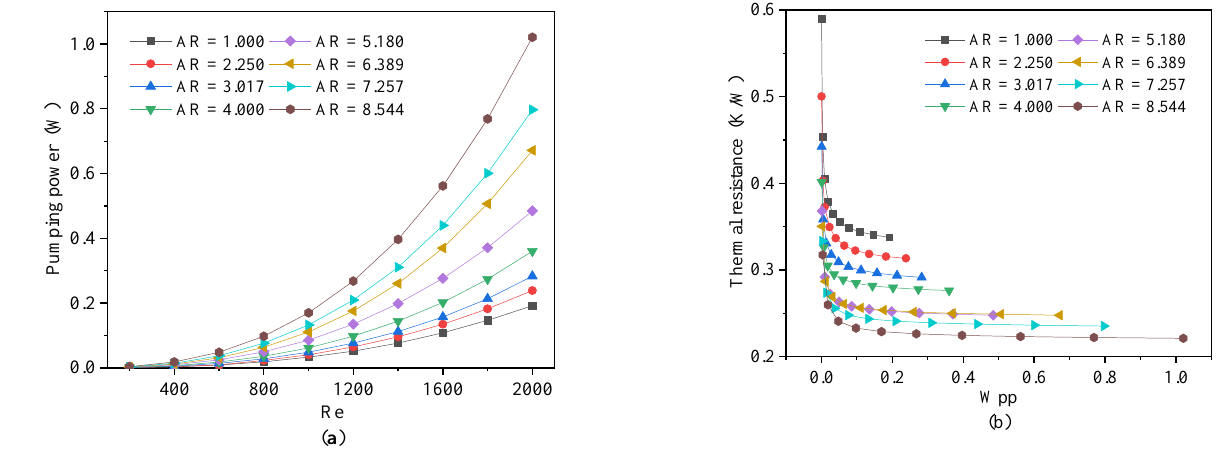
Figure 6. Effect of different aspect ratios on pump power ( a ) and thermal resistance ( b ).